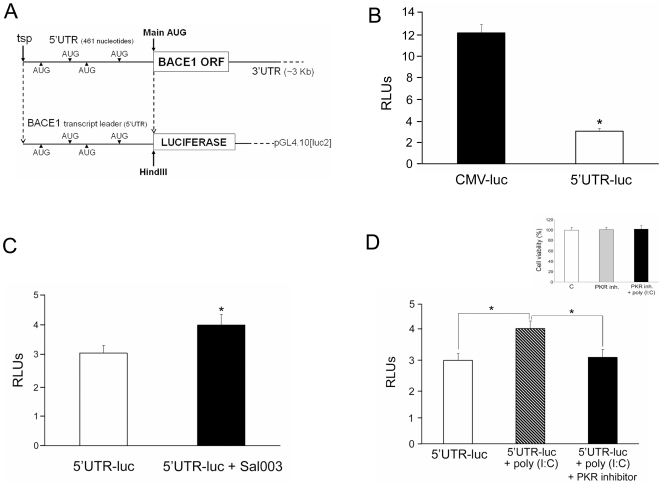
Poly (I∶C) induces BACE1 translation in a mechanism depending on PKR-catalysed eIF2-alpha phosphorylation.BACE1 5′UTR fragment was inserted into the HindIII site of a luciferase reporter construct (5′UTR-luc). The plasmids bear the strong cytomegalovirus promoter (CMV), which allows sufficient reporter gene expression for luciferase determinations. HeLa cells were transfected with 5′UTR-luc or empty plasmids (named as CMV) for luciferase reporter studies (A). 5′UTR-luc repressed translation in comparison with the empty 5′UTR-free luciferase construct (B). Inhibition of eIF2-alpha phosphatase PP1c by Sal003 de-repressed the reporter signal elicited by 5′UTR-luc (C). Stimulation (3 h) with poly (I∶C) also de-repressed the reporter signal yielded by 5′UTR-luc. This effect was abolished when cells were preincubated with a specific and potent PKR inhibitor that acts via the PKR ATP-binding site. Data are mean ± SEM of 3 independent experiments performed in triplicate. *p<0.05 by Student's t test (D). Incubation with the specific PKR inhibitor -in the presence/absence of poly (I∶C)- did not result in a decrease in cell viability as shown by an MTT assay. Data are mean ± SEM of 3 independent experiments performed in triplicate (Inset in panel D).